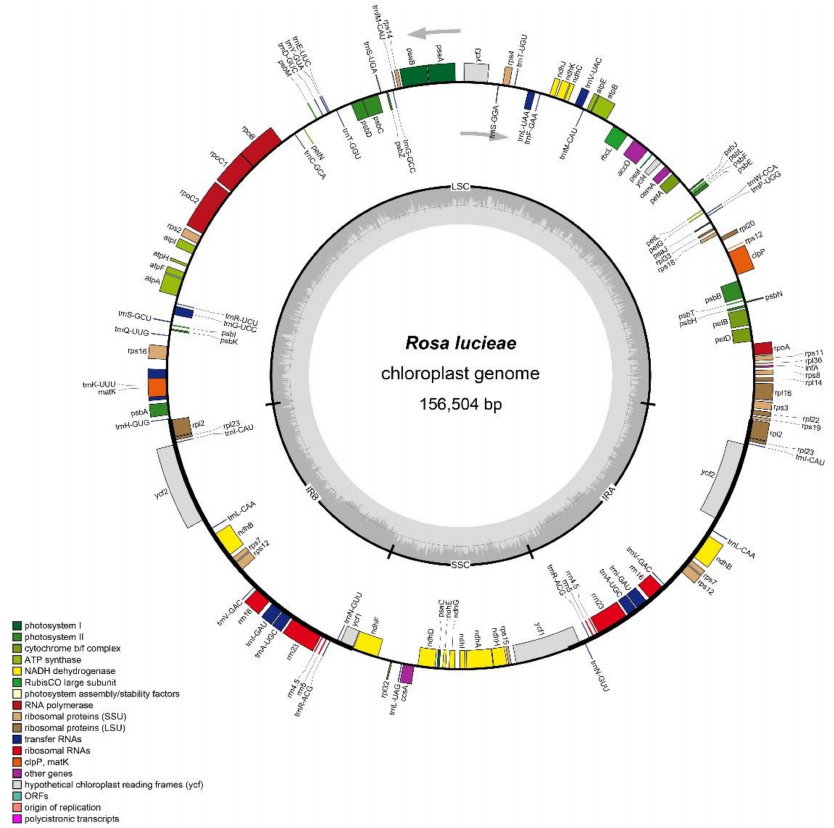
Figure 1. Gene map of the chloroplast genome of R. lucieae